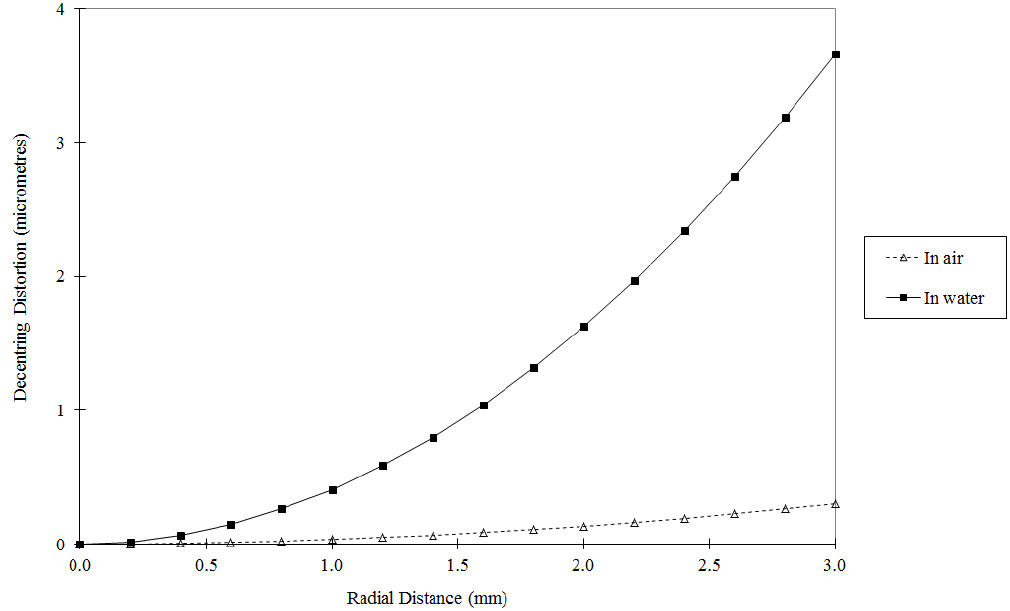
Figure 7. Comparison of decentring lens distortion from in-air and in-water calibrations of a GoPro Hero4 camera operated in HD video mode. Note the much smaller range of distortion values (vertical axis) compared to Figure 6.